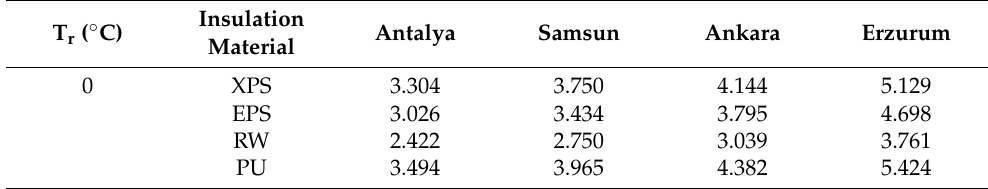
Table 6. Payback periods (year) considering different reference temperatures and four insulation materials in selected